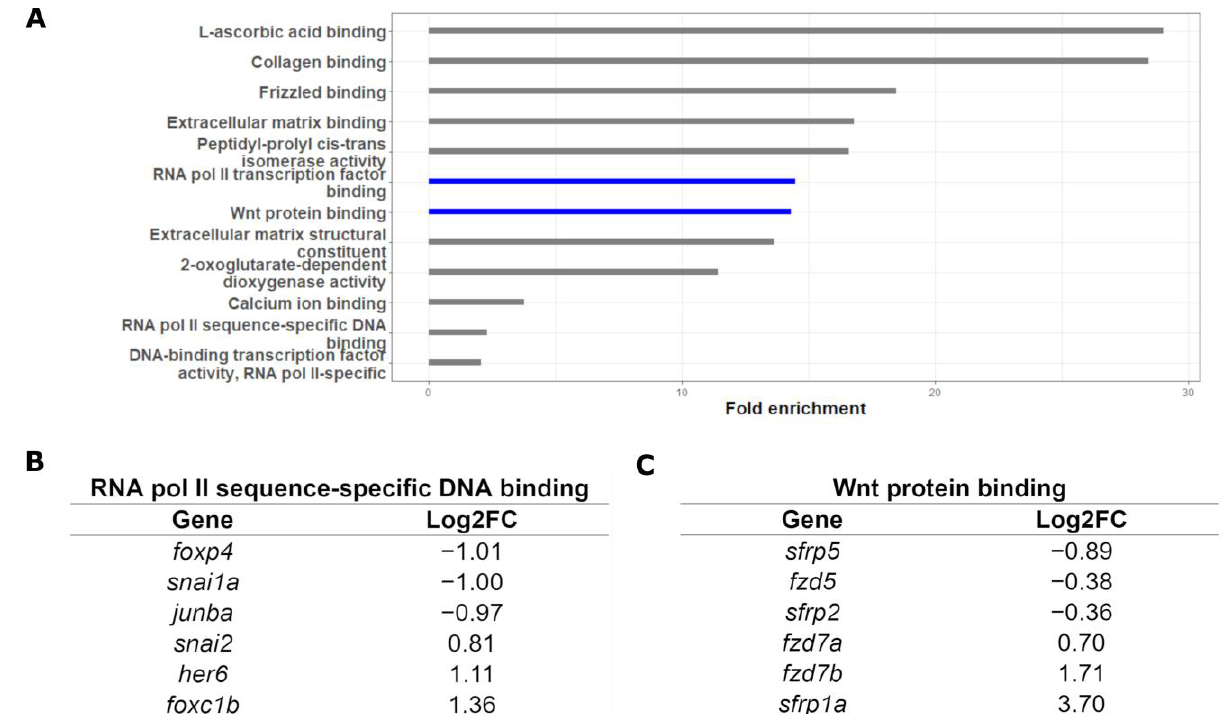
Figure 3. GO analysis of RNA-seq dataset. ( A ) Wnt protein binding and RNA polymerase II transcription-factor binding processes were highly overrepresented. ( B ) Representative genes from the “RNA polymerase II sequence-specific DNA binding” term. ( C ) Representative genes from the “Wnt protein binding” term.